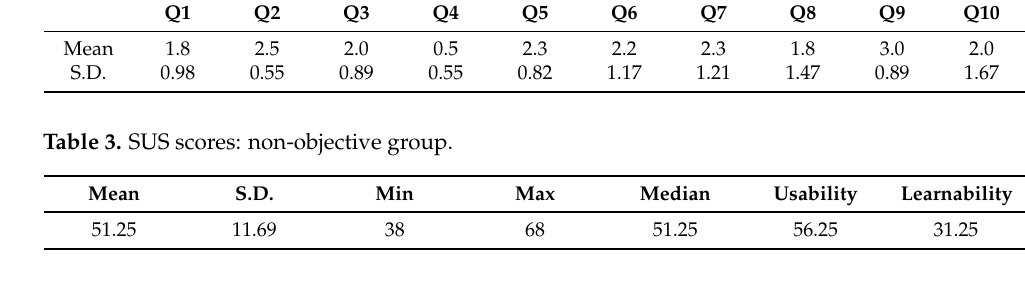
Table 2. SUS items’ mean score contribution (weighted: range 0–4): non-objective group. Q1